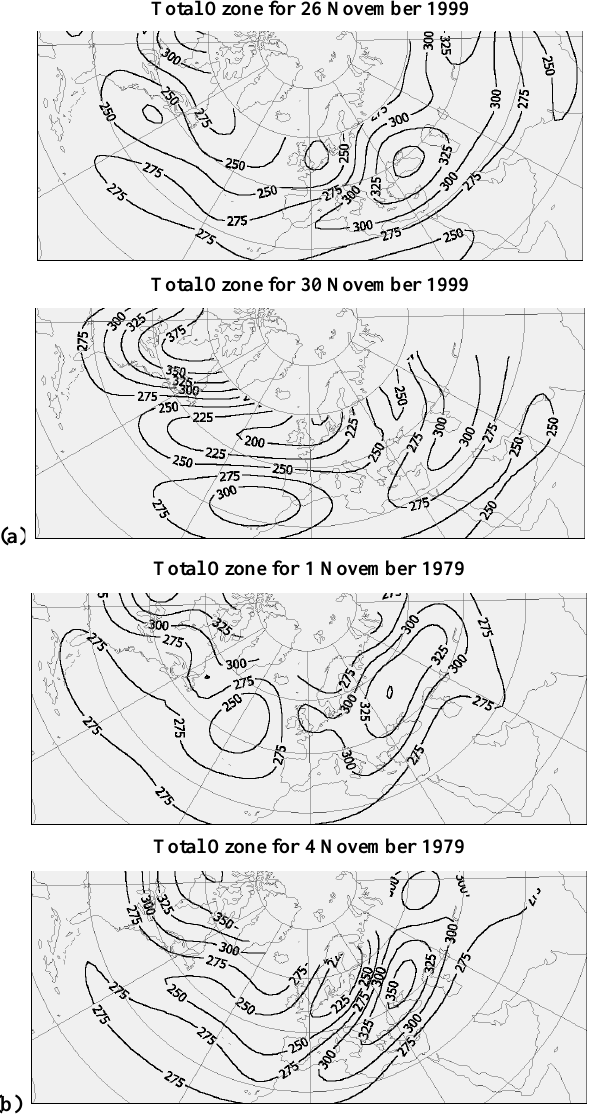
FIGURE 5b Fig. 5a. Total ozone distribution during the 26–30 November 1999 Fig. 5c. Total ozone distribution during the November 1996, ELO 3 episode. During big parts of November 1996 there was a chain of northeastward directed intrusions of air with total ozone less than 250 matm-cm, causing ELO 3 events in